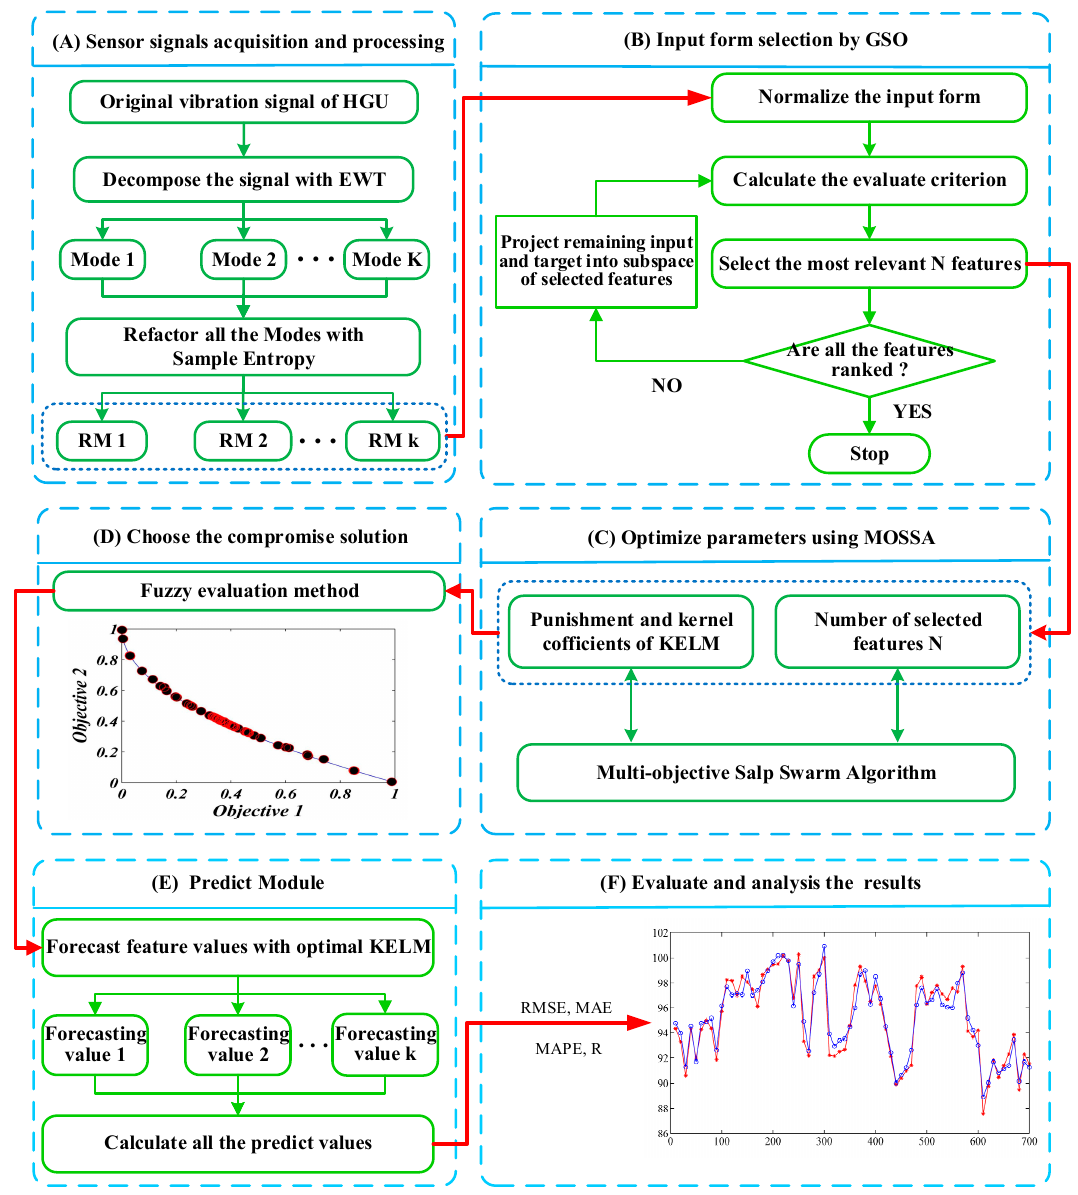
Figure 1. The framework of the proposed model.